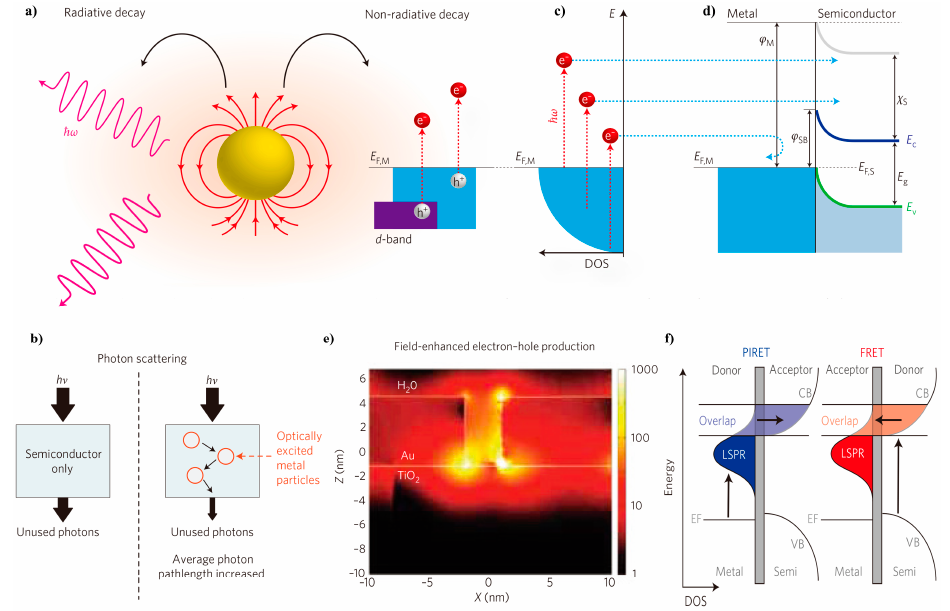
Figure 1. Plasmonic enhancement mechanisms. ( a ) High-energy resonant state decay in two possible forms: re-emission (scattering) of photons or the generation of energetic charge carriers; ( b ) scattering mechanism in which multiple reflections of light among nanocrystals prolong the mean photon path in plasmonic nanostructures and semiconductor composites; ( c ) excitation of electrons from occupied energy levels to a level above the Fermi energy; ( d ) hot electron overcoming the Schottky barrier and injected to the conduction band of the neighboring semiconductor; ( e ) optical simulations using finite-difference time-domain (FDTD) showing SPR-enhanced electric fields around photo-excited Au particles, permeating into a neighboring TiO 2 structure; electric field intensity normalized by the light source intensity (|E| 2 /|E| 02 ) shown by the color bar; ( f ) complementary energy transfer with plasmon-induced resonance energy transfer (PIRET) and Förster resonance energy transfer